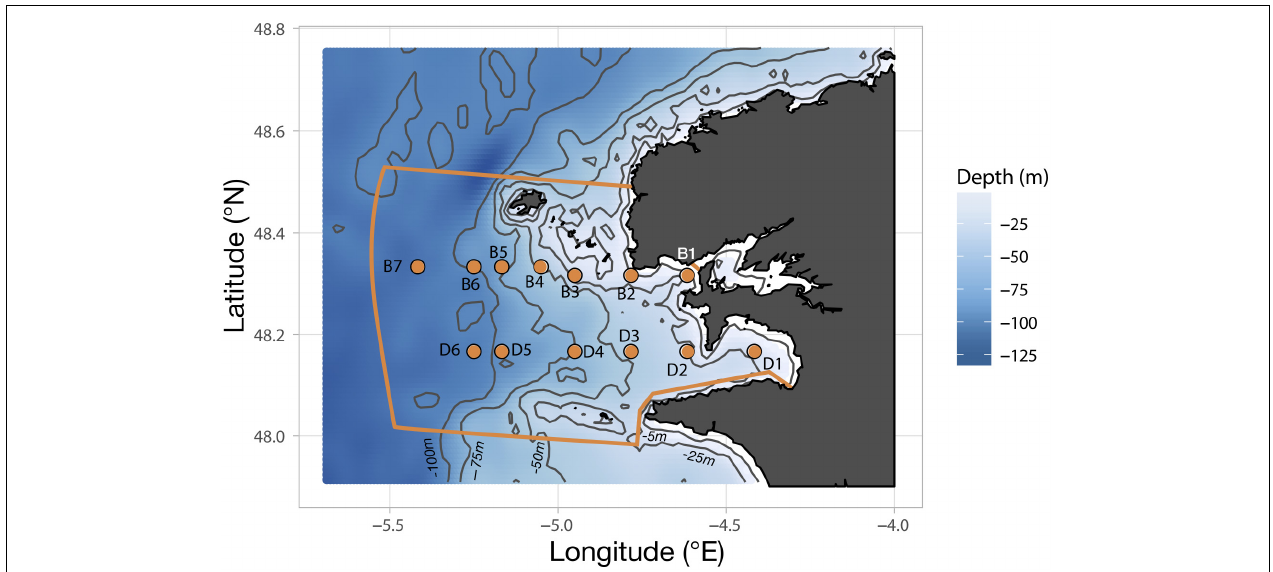
FIGURE 1 | Position of the sampling stations constituting the two transects B and D along the bathymetric gradient of the Iroise Sea. The orange lining delimits the area covered by the “ Parc Naturel Marin d’Iroise ”